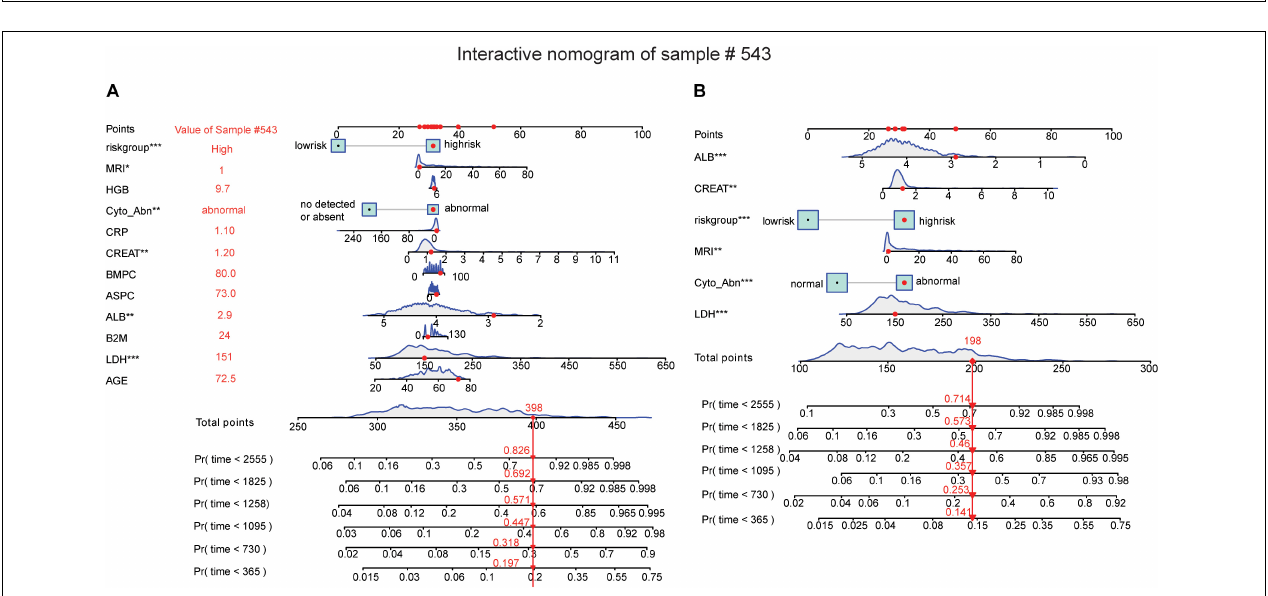
FIGURE 6 | Nomogram predicting 1-year, 3-year, 5-year, and 7-year overall survival of multiple myeloma patients. (A) The nomogram consists of the eleven clinical risk indicators and five-gene risk group. Add the points from these twelve variables together to find the location of the Total Points. The Total Points projected on the bottom scales indicate the probability of 1-year, 3-year, 5-year, and 7-year overall survival. (B) The calibration curves for predicting 1-year, 3-year, 5-year, and 7-year overall survival. The Y -axis represents actual overall survival, the X -axis represents the nomogram-predicted overall survival. The gray line indicated that prediction agrees with actuality. Error bars represent 95% confidence intervals.